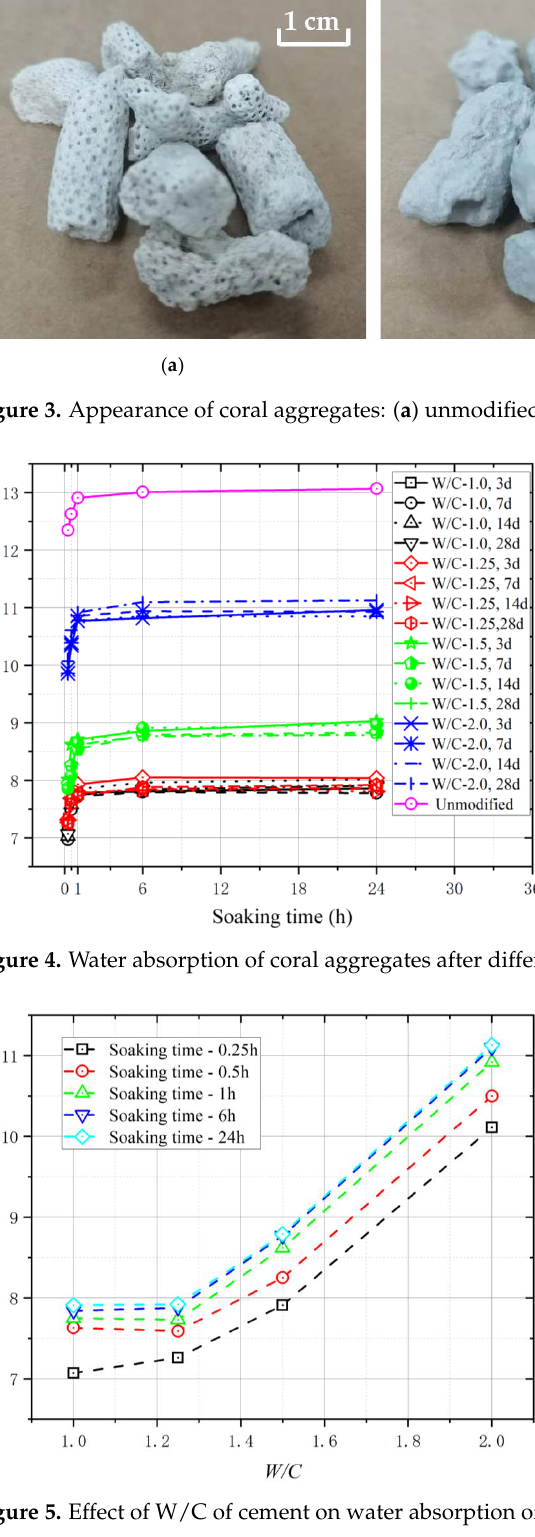
Figure 6. Comparison of water absorption of different types of aggregates [53,54]. 2 2 . 444 . 378 . 96 